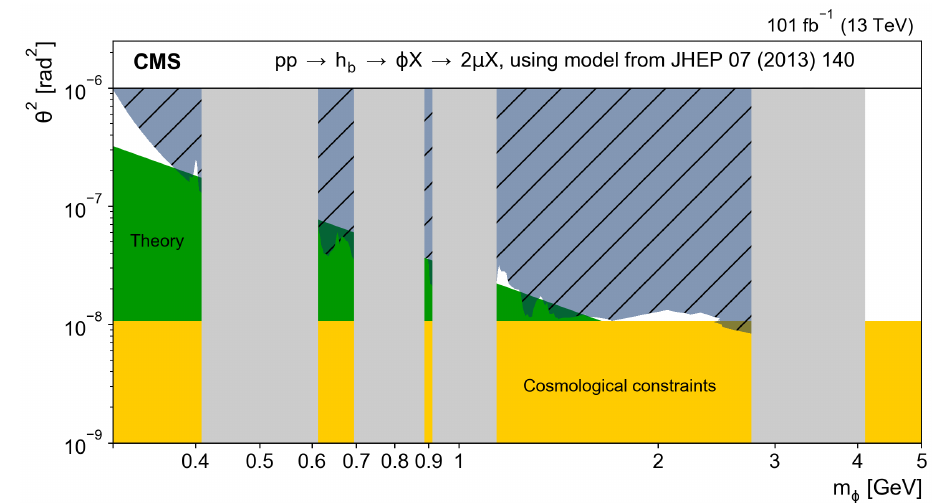
Figure 11 . Region excluded at 95% CL using this search (shown in hatched gray) for the inflaton model [15] in the parameter space containing the signal mass ( m ) and the square of the signal φ mixing angle ( θ 2 ). The regions forbidden by theory and cosmological constraints are shown in green and yellow respectively. The vertical gray bands indicate mass ranges containing known SM resonances, which are masked for the purpose of this search. The limits are obtained using the combination of all dimuon event categories.